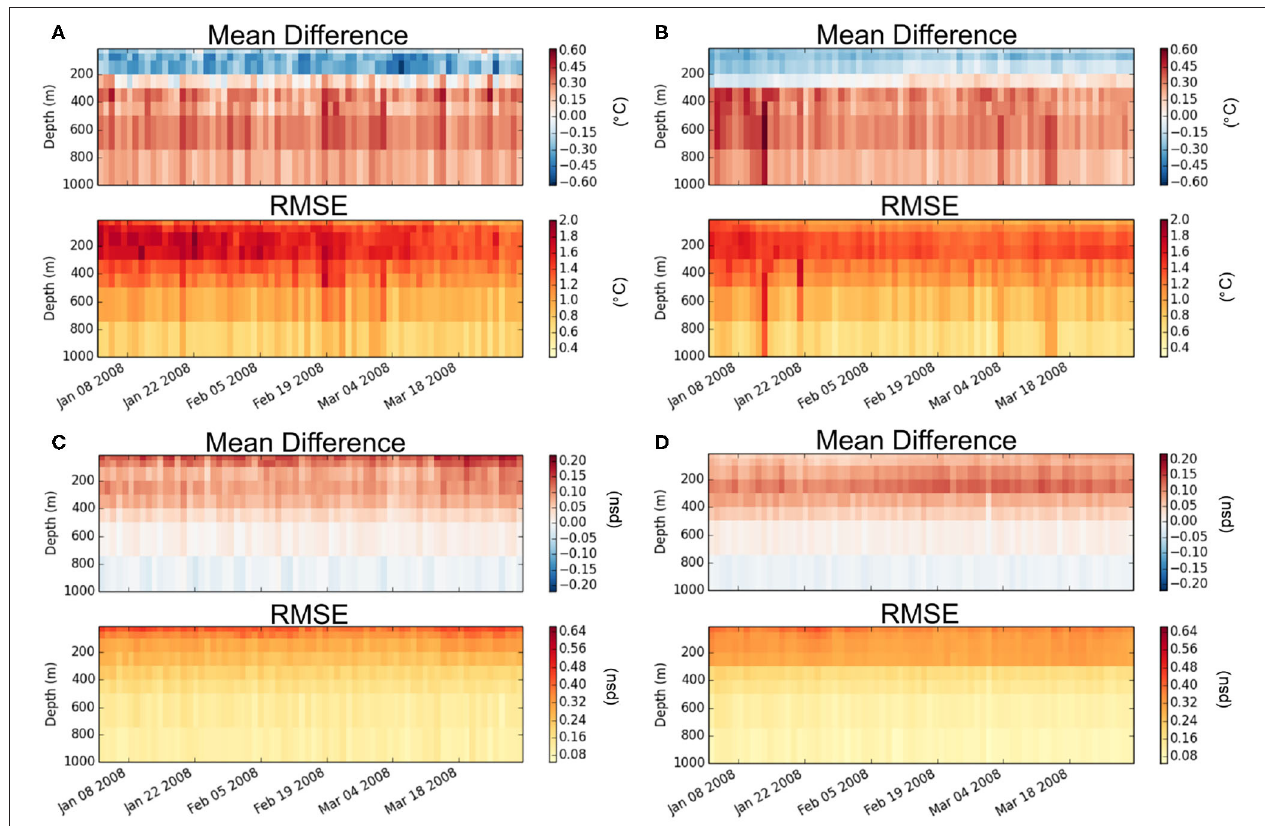
FIGURE 2 | Hovmöller plots of observation-minus-model (O-M) statistics for temperature and salinity fields averaged over the Global Ocean from the free runs verifying real and synthetic observations during January–March 2008: (A) real temperature observations, (B) synthetic temperature observations, (C) real salinity observations, and (D) synthetic salinity observations. Each subplot includes two panels showing the mean differences in the top panel and root mean square (RMS) in the bottom